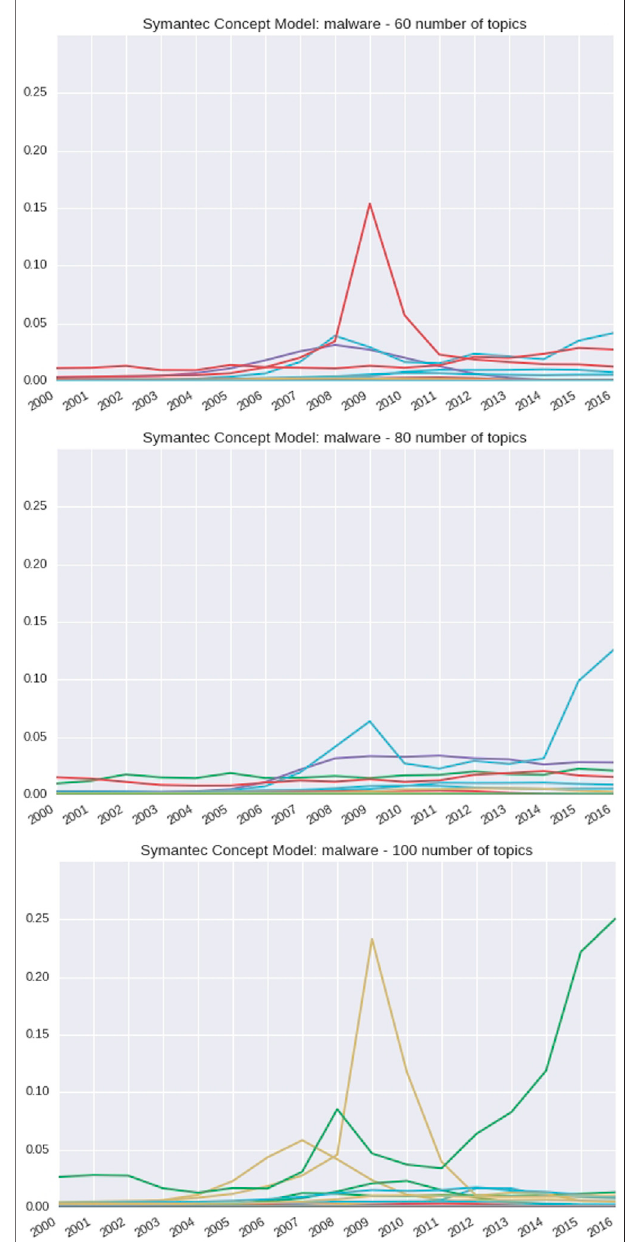
FIGURE 7 | 60-, 80-, and 100-topic Symantec Malware reports of the DTM concept: Malware.